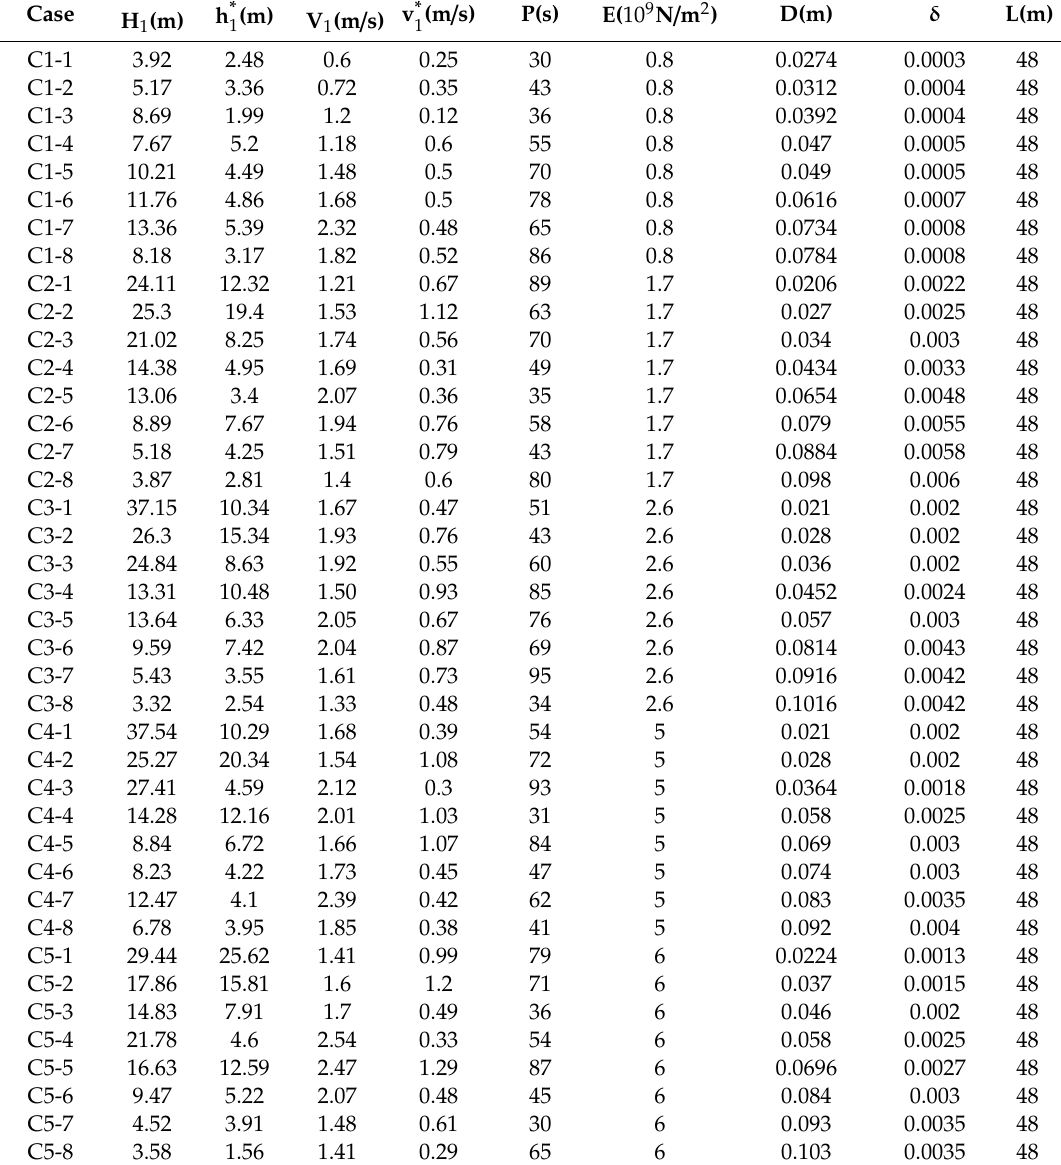
Table 1. Physical parameters of oscillating water flow and pipe used in the